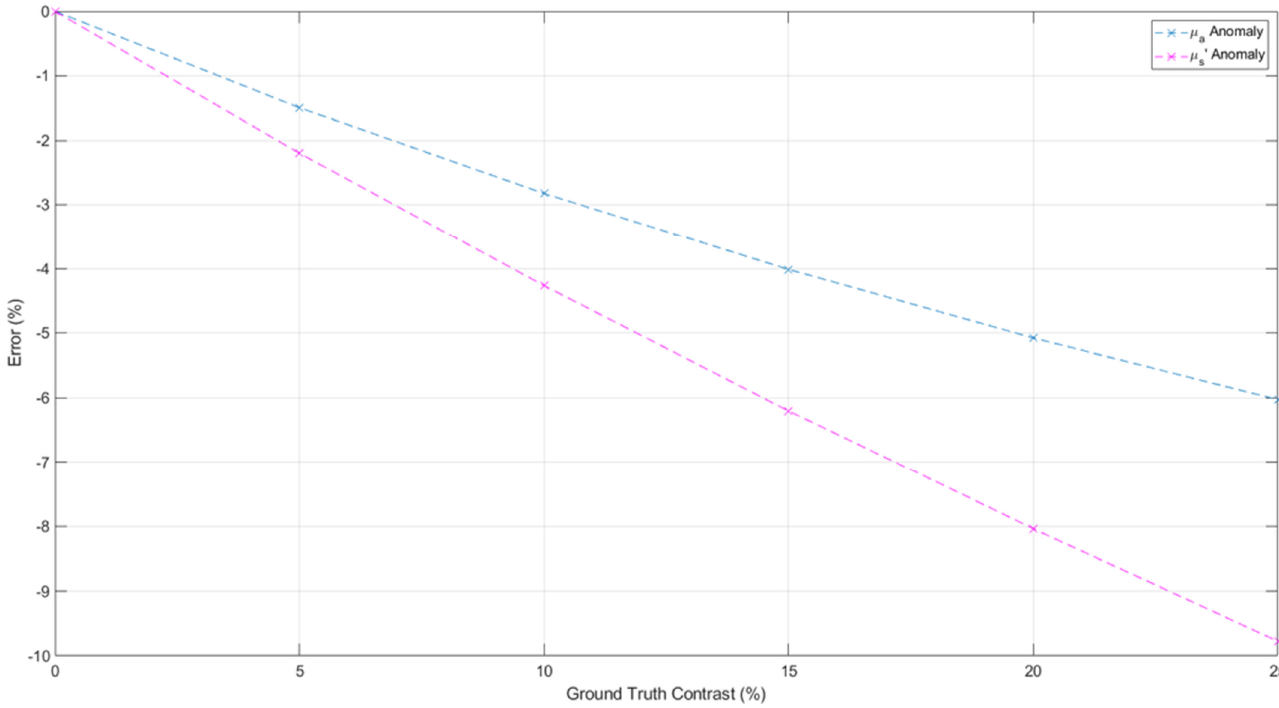
Figure 8. Tri-anomaly model, single optical property variation recovery errors for absorption only and reduced scattering only. The recovery errors are determined using Equation (8), for the full range of optical properties simulated, to a maximum of 25% increase compared to background and calibration phantom values.